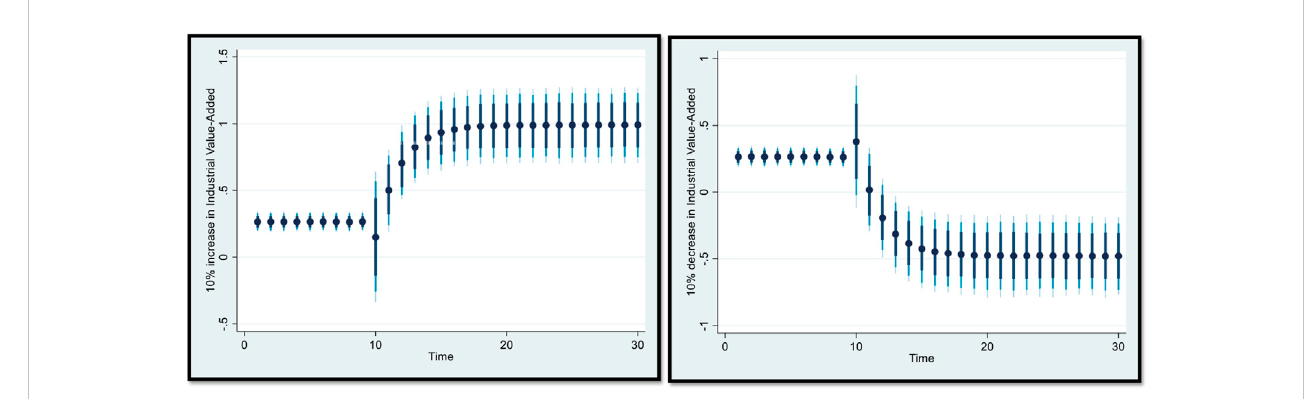
FIGURE 6 Impulse response plot for industrial value-added and CO 2 emissions. An increase and a decrease of 10% in industrial value-added and its effect on CO 2 emissions, where dots denote the average prediction value. The dark blue to light blue lines show 75%, 90%, and 95% con fi dence intervals, respectively.